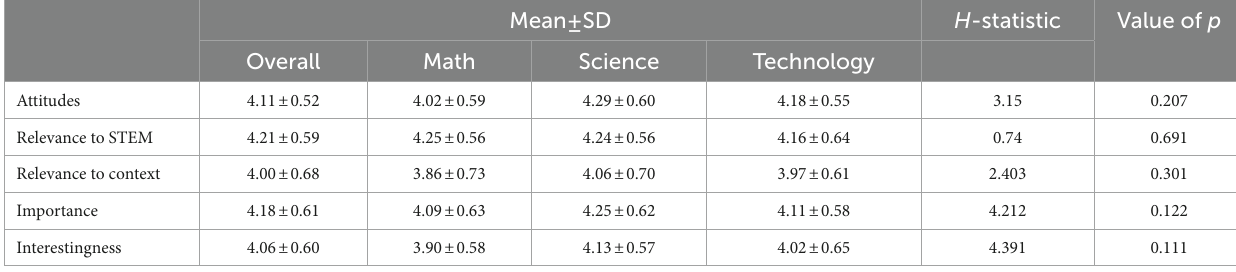
TABLE 1 Surveyed teachers’ attitudes toward integrating CE in STEM